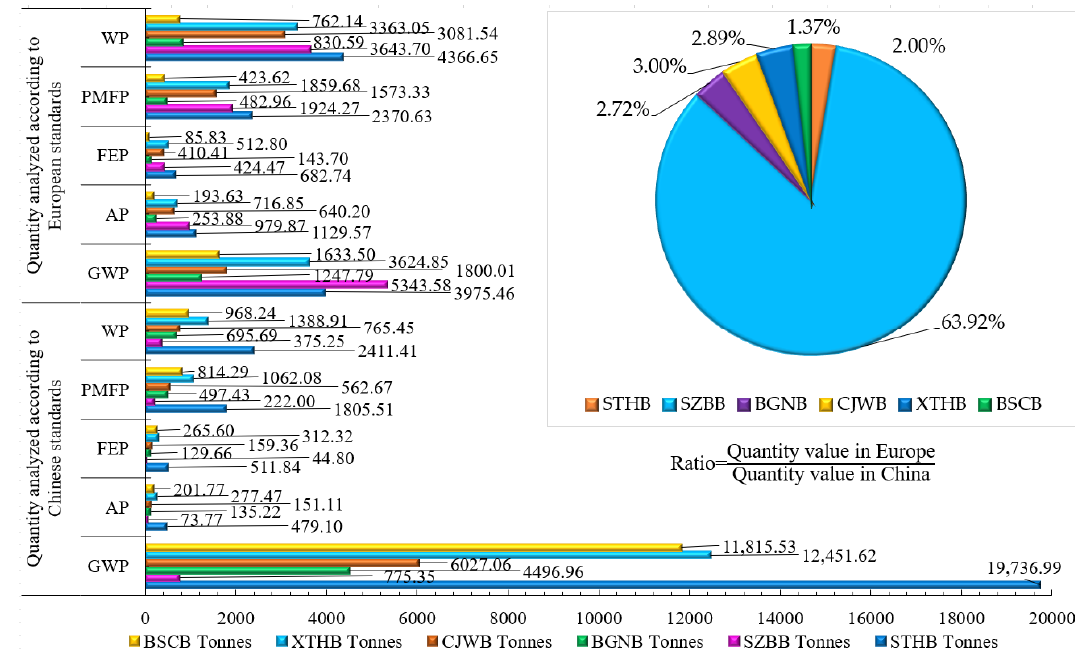
Figure 6. Environmental impact contribution diagrams of six cable-stayed bridges at various stages.